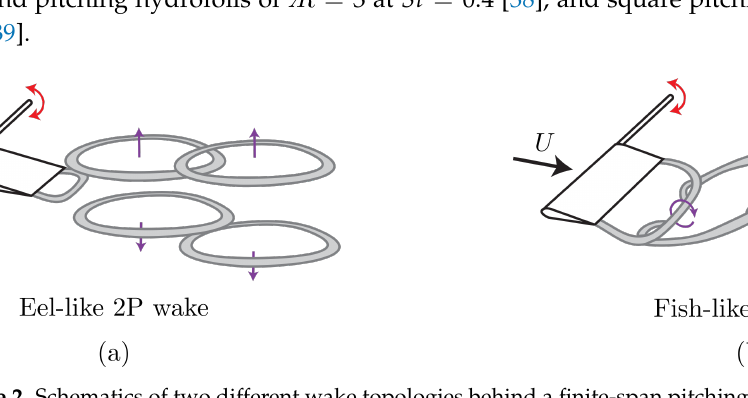
Figure 2. Schematics of two different wake topologies behind a finite-span pitching hydrofoil where ( a ) vortex rings bifurcate away from each other in the cross-stream direction as they advect downstream, commonly seen in eel-like swimming, and ( b ) interconnected vortex rings advect downstream, commonly seen in fish-like